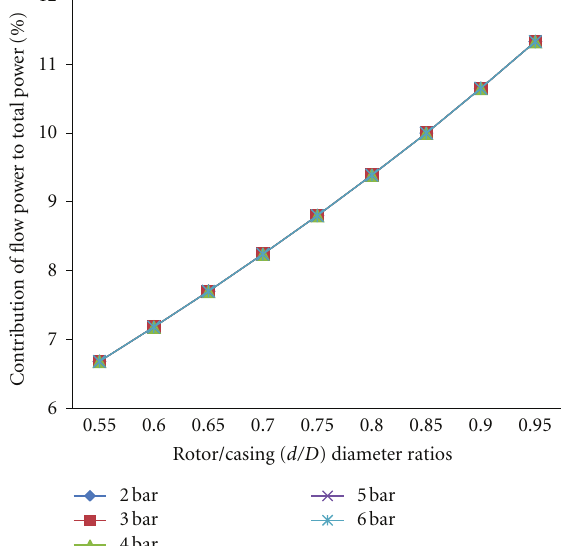
Figure 4: Exit flow power versus rotor/casing diameter ( d/D ) ratio when D = 100 mm.